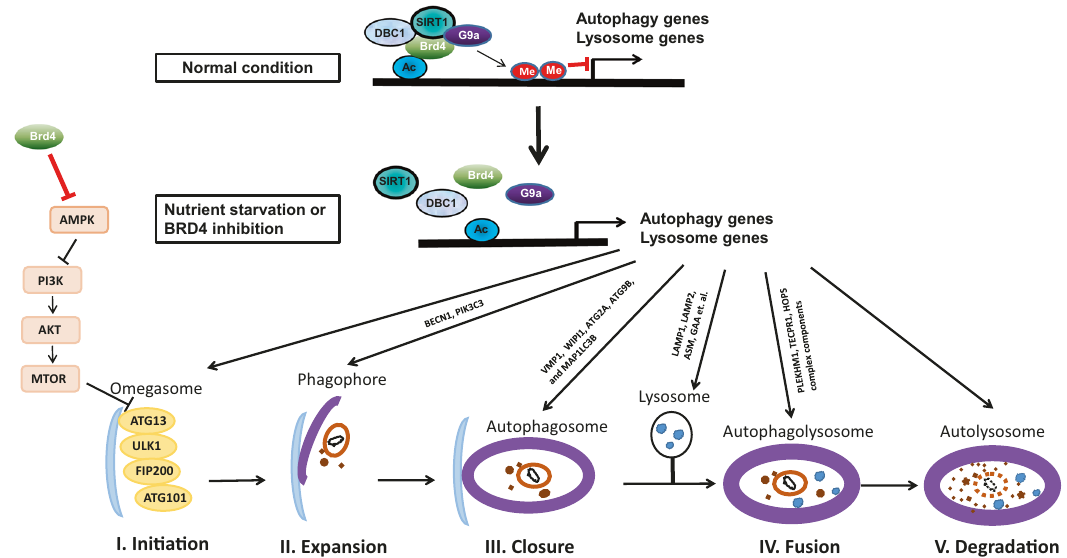
Fig. 2 Model of Brd4 modulating autophagy. In normal condition, Brd4 occupies the promoter region with DBC1, SIRT1 and G9a and represses the expression of genes involving in the fi ve phases of autophagy. In the case of starvation or Brd4 inhibition, Brd4 is displaced from chromatin instigating autophagy and lysosome-related genes activation. In addition, Brd4 can prevent autophagy via interacting with AMPK and then activating PI3K-AKT-MTOR